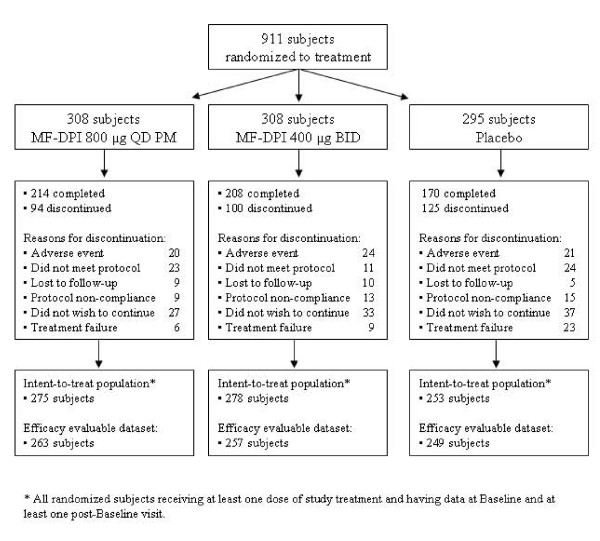
Disposition of study subjects.